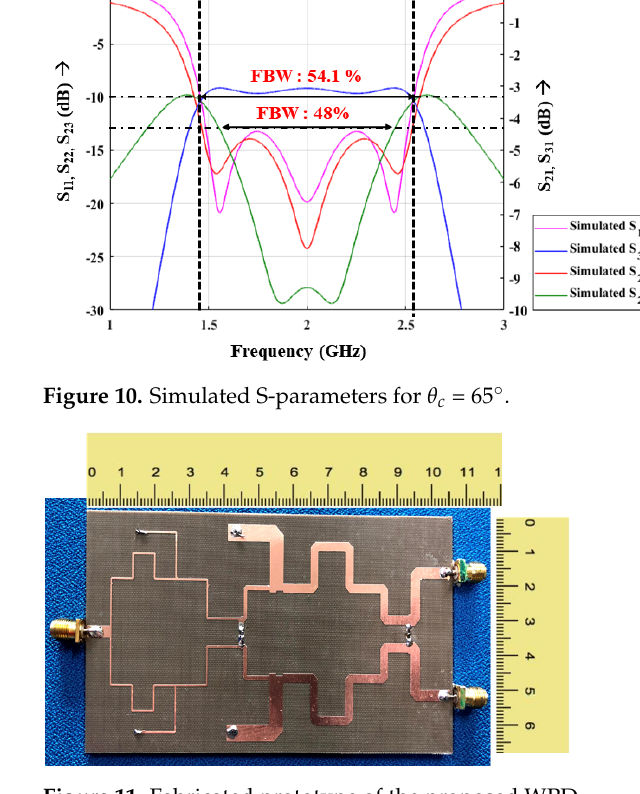
Figure 11. Fabricated prototype of the proposed